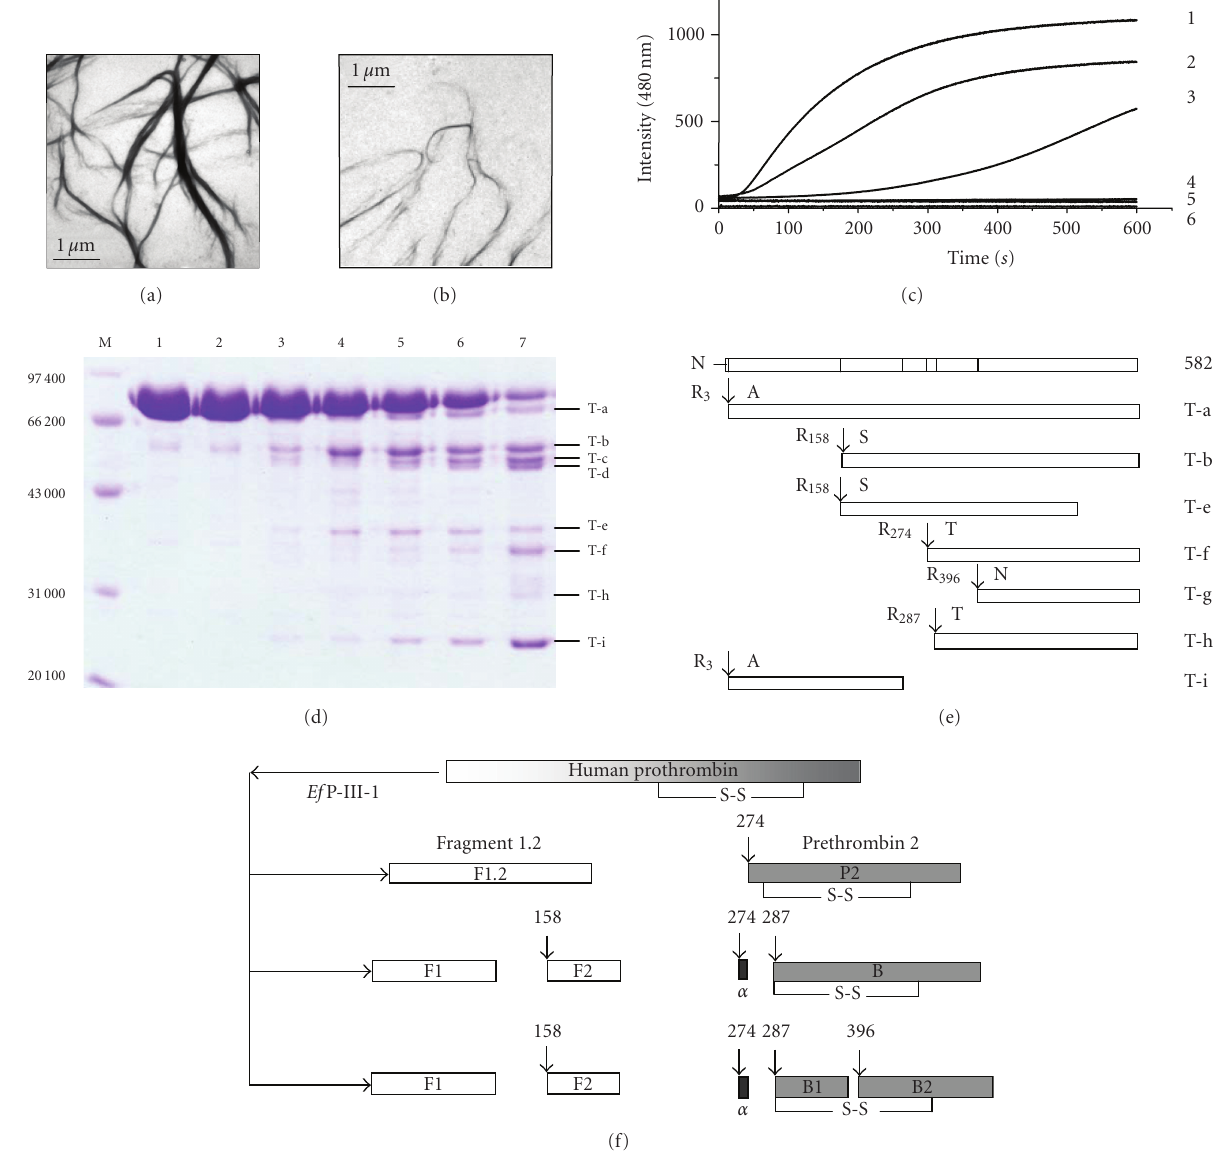
Figure 4: Activation of prothrombin by Ef P-III-1. Prothrombin (2mg/mL final concentration) in 50mM Tris-HCl bu ff er (pH 7.4) was incubated with (a) or without (b) Ef P-III-1 at 25 ◦ C, and then added into fibrinogen and observed by electron microscopy. Activation of Ef P-III-1 on prothrombin was measured by light scattering assay (c). Thrombin was added to fibrinogen in the absence of Ef P-III-1 as a control (curve 1); prothrombin (curve 3) or thrombin (curve 2) was incubated with Ef P-III-1 before addition to fibrinogen; prothrombin (curve 4) or Ef P-III-1 (curve 5) was added to fibrinogen as controls, and Tris-HCl bu ff er as a negative control (curve 6). Prothrombin in the presence of Ef P-III-1 was electrophoresed on 12% SDS-PAGE (d). M: low-molecular-mass protein markers; lane 1: prothrombin alone; lanes 2 through 7: hydrolyzed products after 0, 5, 15, 30, 60, 120 minutes, respectively. T-a to T-i represent the digested fragments of prothrombin in the presence of Ef P-III-1 (e). Diagrammatic representation of prothrombin activation products produced by incubation with Ef P-III-1 was shown in